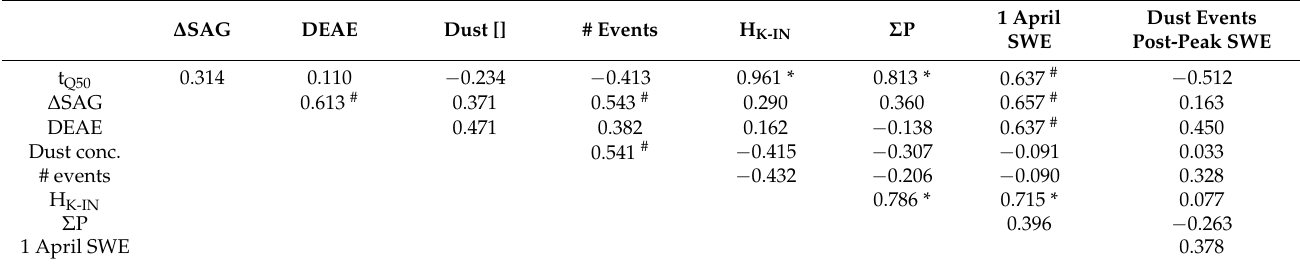
Table 1. Cross-correlation as the coefficient of determination (R) between climate variables (H K-IN is the incoming shortwave radiation, dust conc. = concentration, Σ P is cumulative from 1 April to SAG), daily mean DEAE, and ∆ SAG. The values of R are given rather than R 2 to indicate the sign of the correlation. Note: # is used to denote correlations where R 2 > 0.29, and * where R 2 > 0.5.